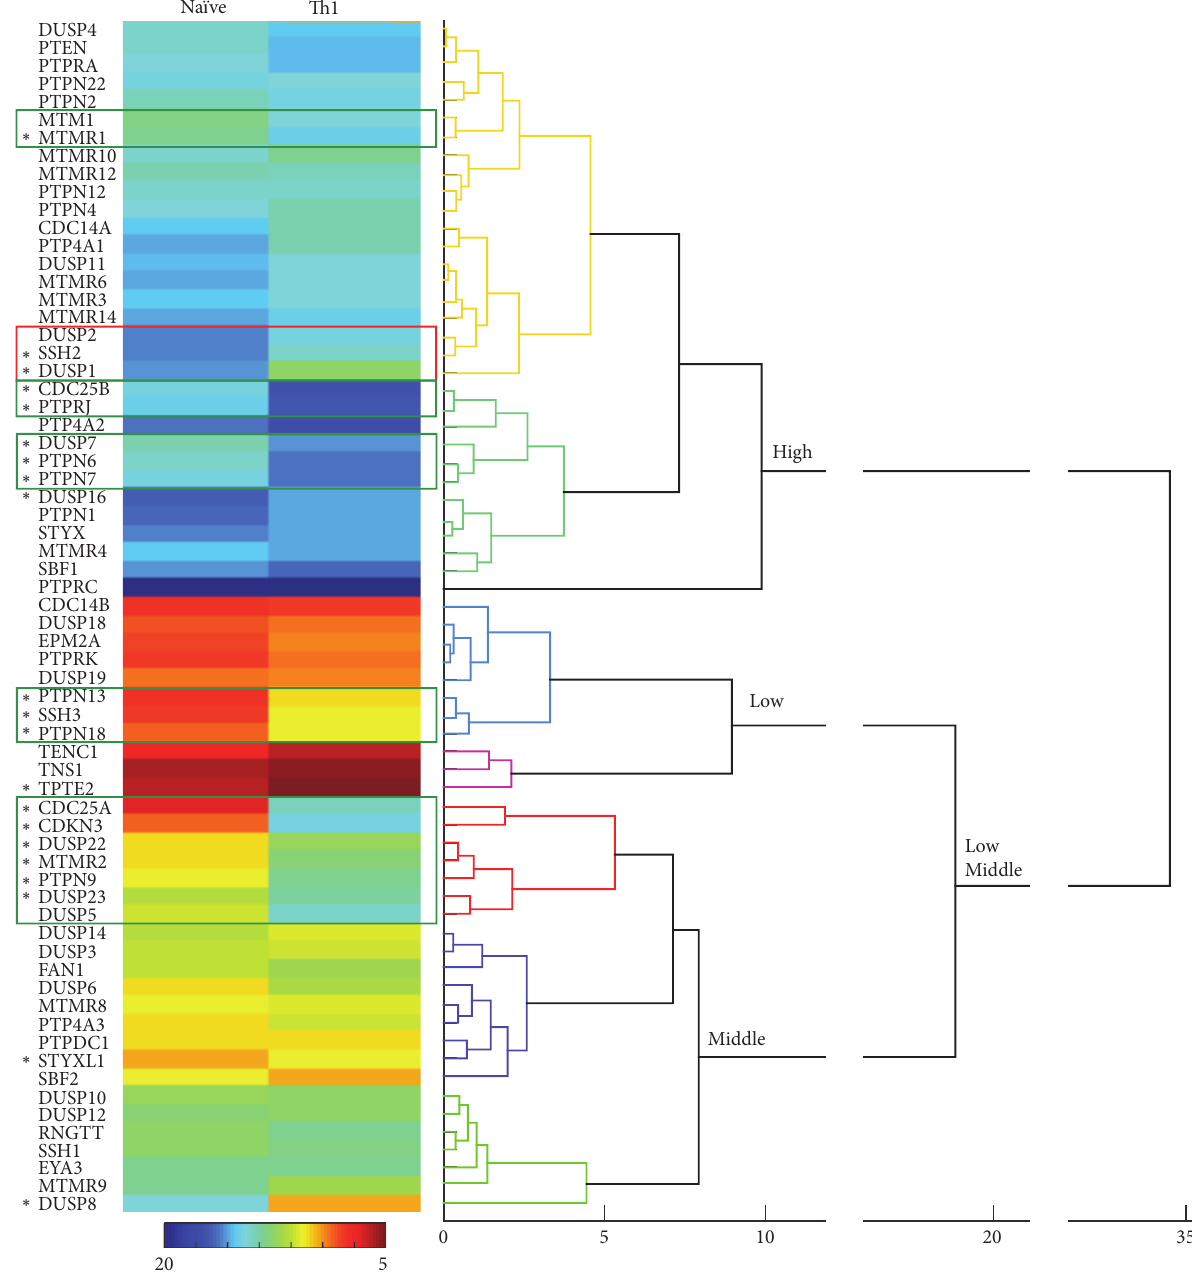
Figure 2: Agglomerative hierarchical tree of the gene expression patterns in na¨ıve and Th1 cells. Numbers below the tree indicate the distance among gene patterns. Hitmap represents the average DCT obtained for each gene in both conditions and 3 donors. The calibration bar is shown between 5 and 20 DCTs. Green and red squares point to clusters of upregulated and downregulated genes, respectively. Asterisks indicate those genes whose expression levels were considered to significantly change, as detailed in Table 2, and explained in materials and methods. Clusters are indicated of high, middle, and low